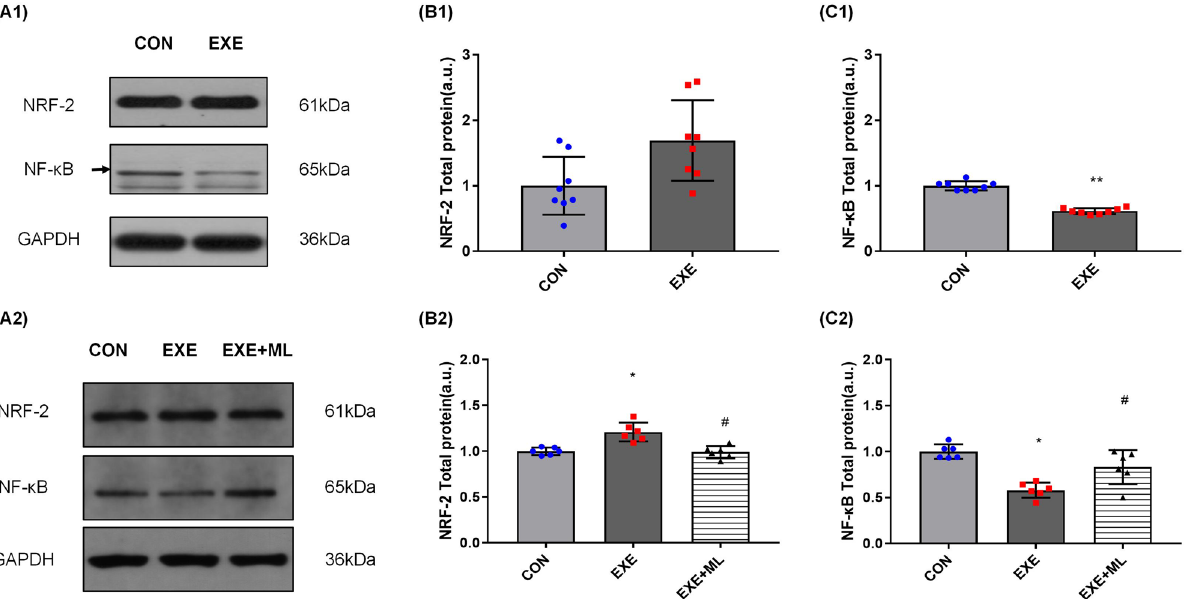
Figure 2. ( A1 – C1 ): NRF-2 and NF-κB protein expression, normalized against GAPDH, in rat’s kidney. Data are means ± SD (n = 8). ** Significantly different from CON ( p < 0.01). ( A2 – C2 ): NRF-2 and NF-κB protein expression, normalized against GAPDH, in NRK-52E cells 24 h after exposure to 10% serum without exercise (CON), serum with exercise (EXE) or serum with exercise supplemented with ML385. Data are means ± SD (n = 6). * Significantly different from CON ( p < 0.05), # Significantly different from EXE ( p < 0.05).